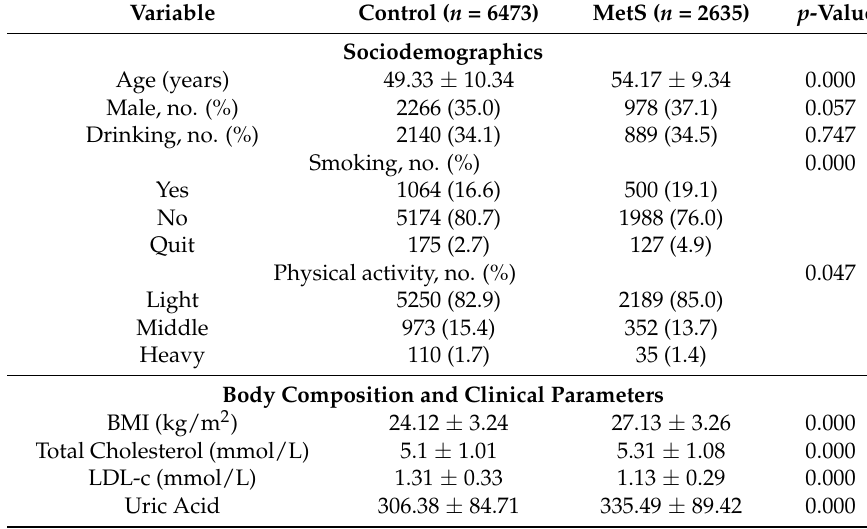
Table 1. Selected characteristics of subjects from the with and without metabolic syndrome groups including sociodemographics, body composition, and clinical and metabolic